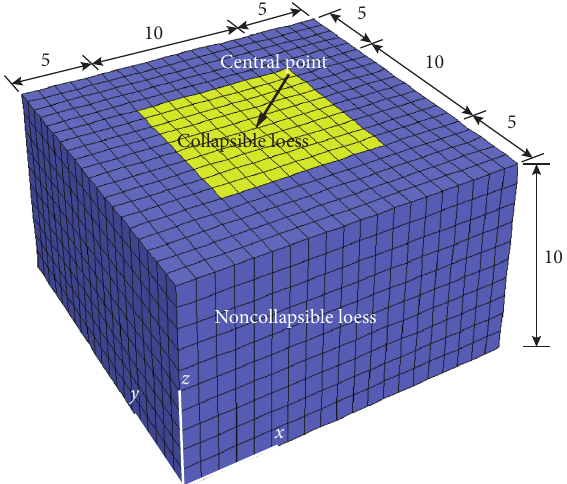
Figure 3: Mesh layout of the calculation model (unit: